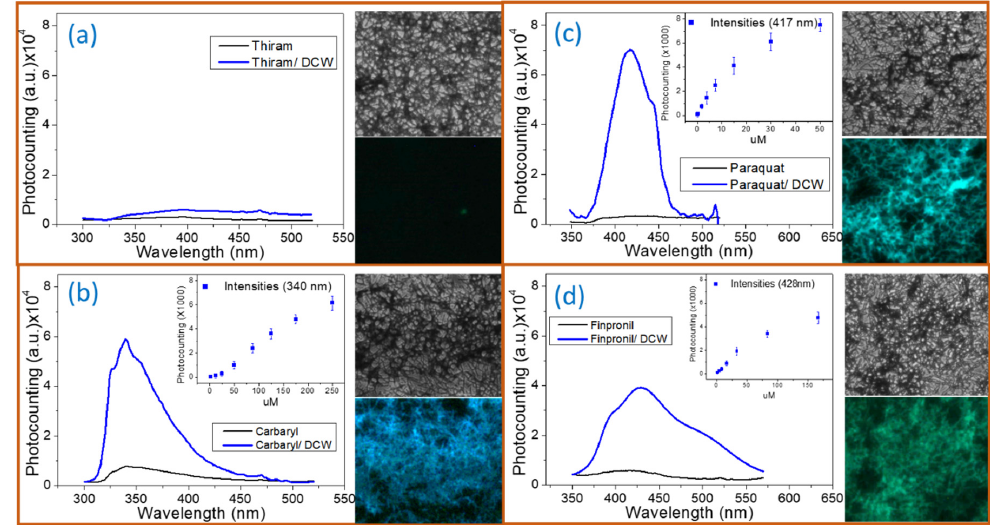
Figure 7. Emission spectra, bright-field (top) and fluorescent images (bottom), for ( a ) thiram, ( b ) carbaryl, ( c ) paraquat, and ( d ) fipronil; the UV-light cube was used for detection of fluorescence microscopy. Inserts in the spectra figures present the nonlinear PEF effects with increasing portions of pesticides.